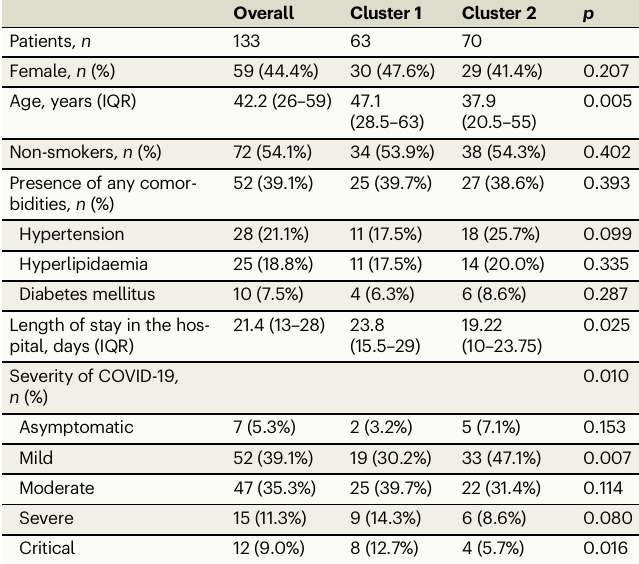
Table 1 | Comparison of clinical characteristics in COVID-19 patients strati fi ed by the integrative multi-kingdom